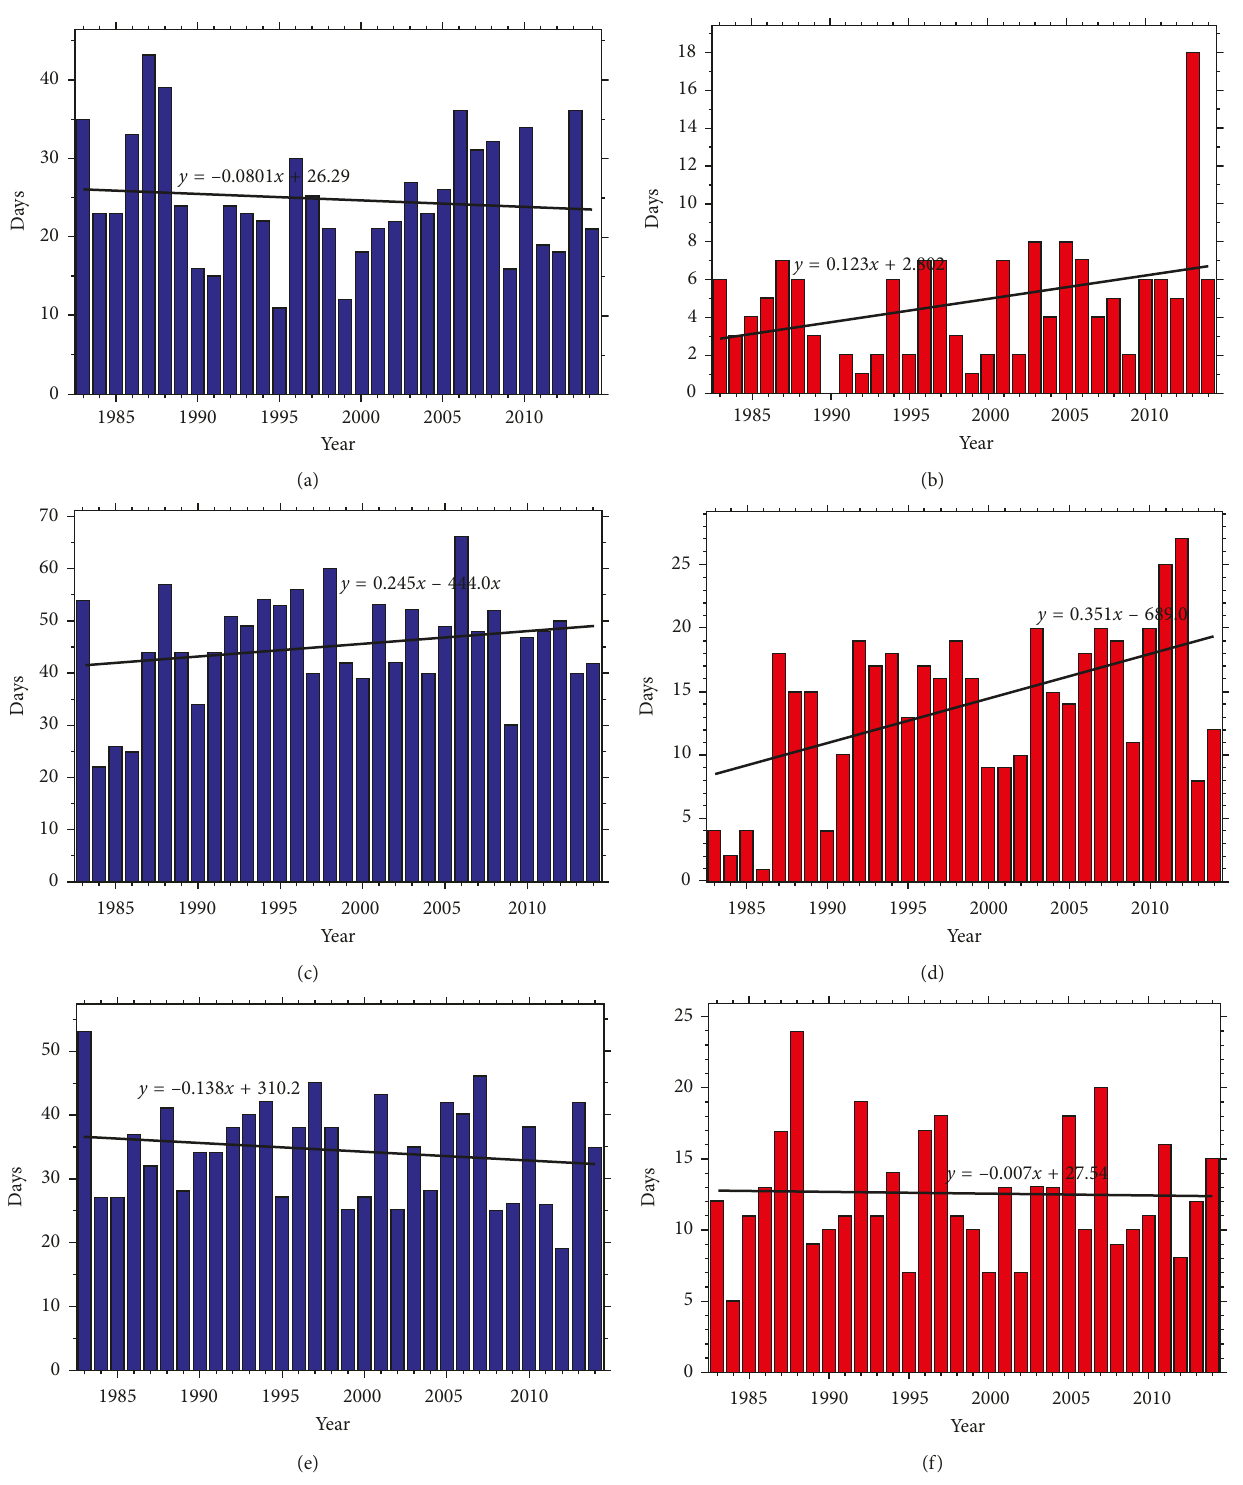
Figure 9: Trends of number of heavy precipitation days (R10mm) over three agroecological zones, (a) lowland, (c) midland, and (e) highland, and for number of very heavy precipitation days (R20mm), (b) lowland, (d) midland, and (f) highland, for the period